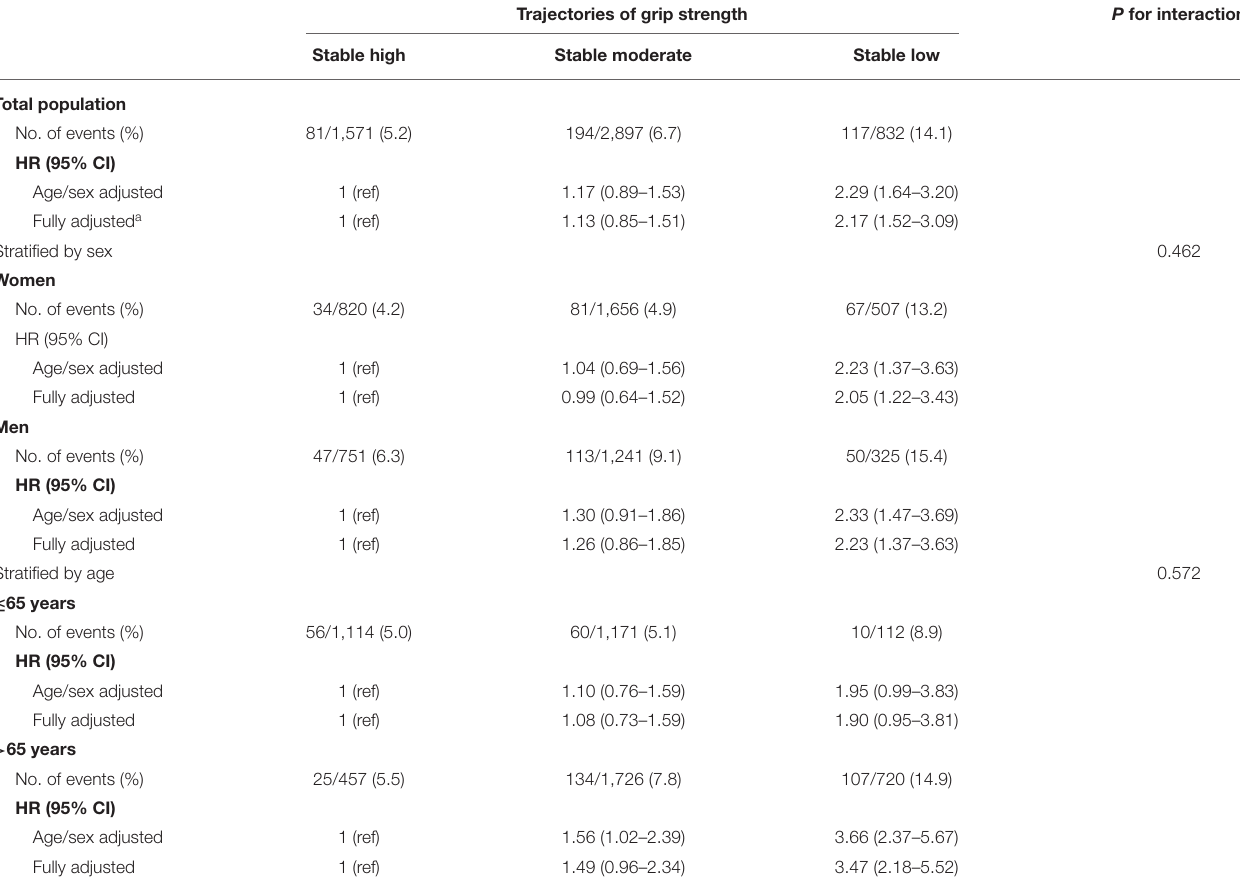
TABLE 2 | Cox regression analyses for CVD incidence per trajectory of grip strength (2004–2012). Trajectories of grip strength P for